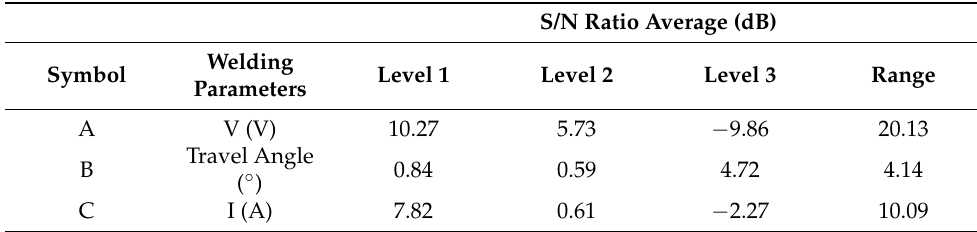
Table 8. S/N Ratio Response to Weld Bead Width.